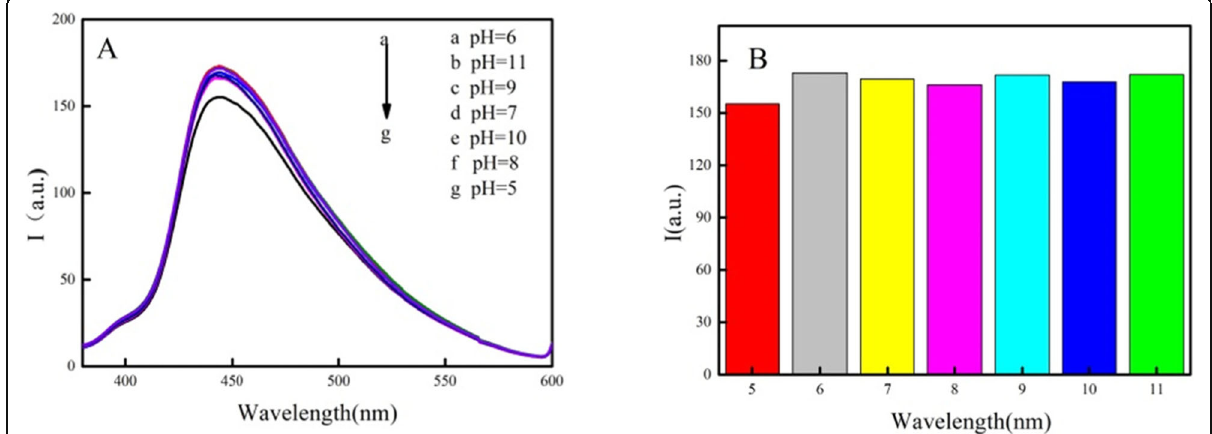
Fig. 5 Effect of pH on the detection of